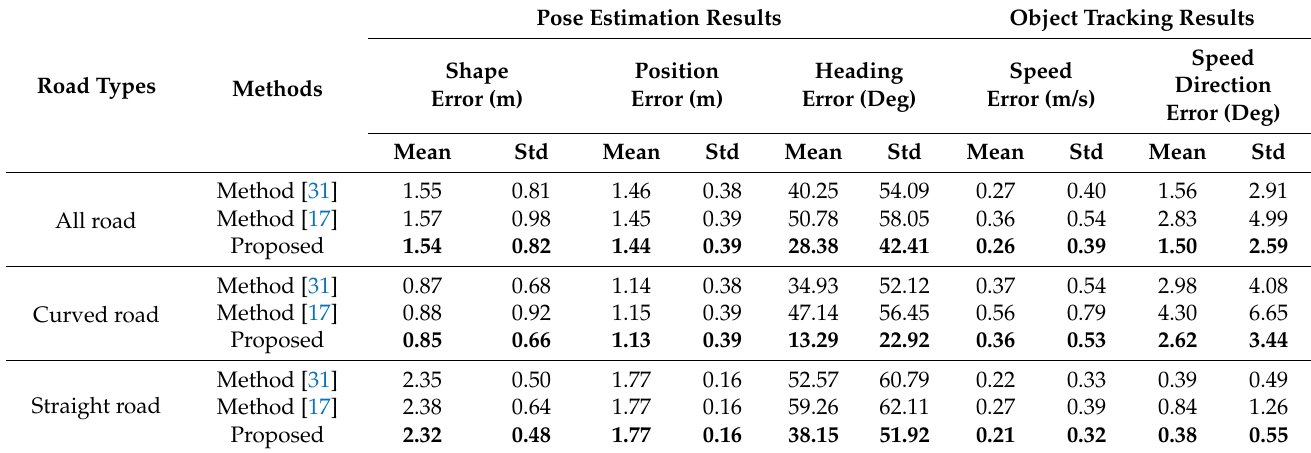
Table 6. The experimental results of our experimental platform.